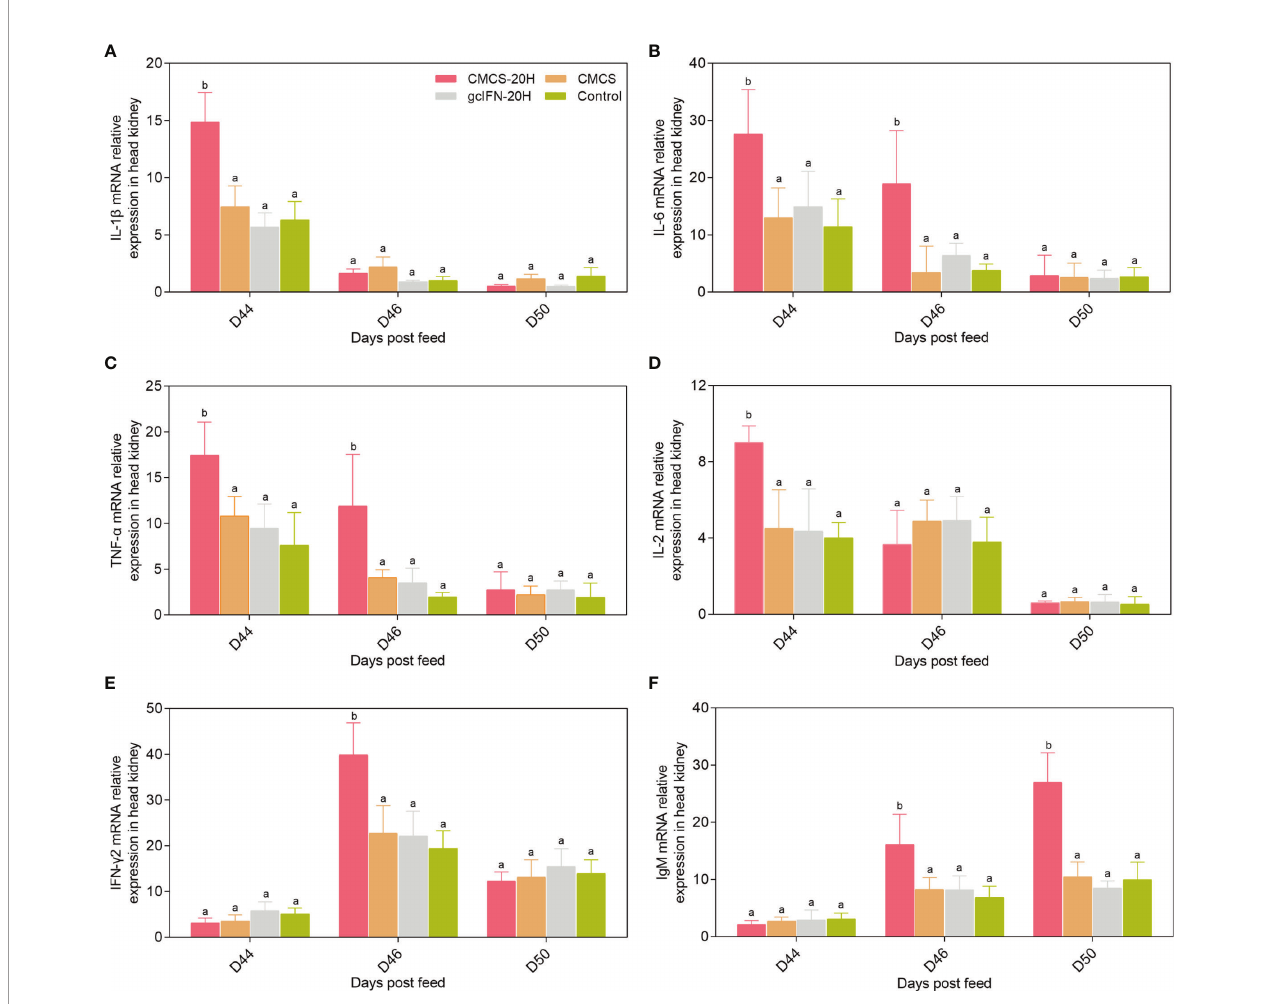
FIGURE 6 | mRNA expression patterns of representative important immune regulation and effector genes in head kidney. (A – F) mRNA expressions of IL-1 b , IL-6, TNF- a , IL-2, IFN- g 2, and IgM were determined by qRT-PCR. 18S rRNA gene was used as an internal control gene. Data are presented as means ± SD ( n = 4). Different lowercase letters in each group (a and b) denote signi fi cant variations suggested by the Kruskal-Wallis statistics followed by the Dunn ’ s multiple comparison (p <